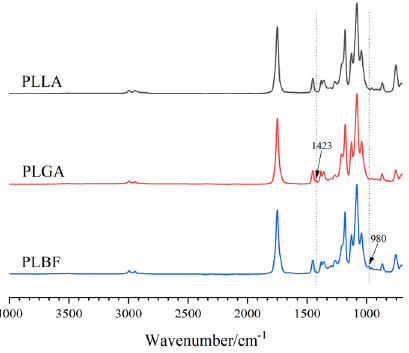
Figure 1. ATR-FTIR spectra of PLLA, PLGA, and PLBF.